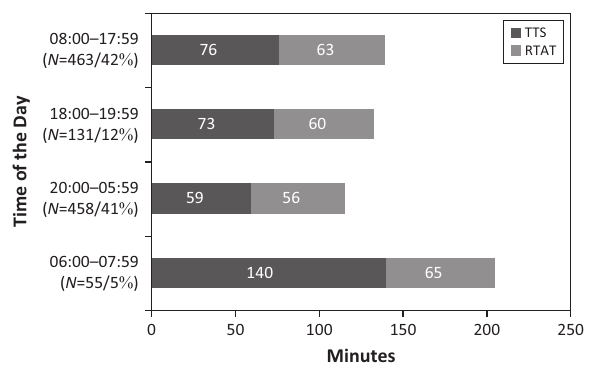
FIGURE 2: Time to scan (TTS) and report turnaround time (RTAT) during different work-hour shifts including number of patients ( N ) and percentage of the total.